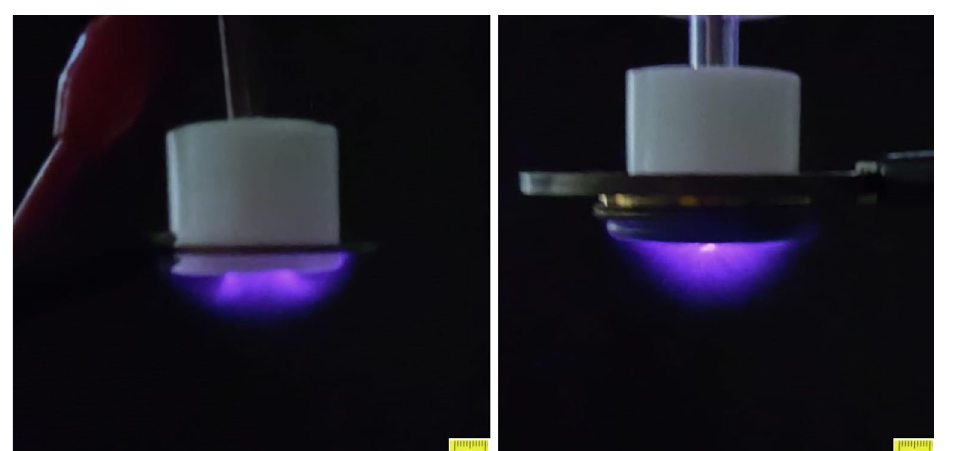
Figure 7. Schematic diagram of JDBD experimental setup.